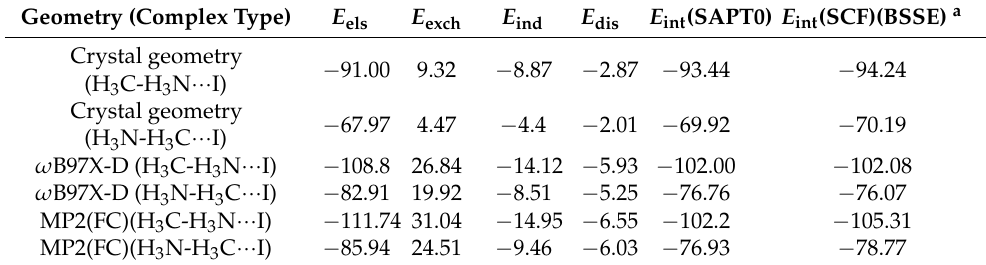
Table 2. Comparison of total and dissected energy SAPT0 components with the SCF based interaction energies of H 3 C-H 3 N ··· I and H 3 N-H 3 C ··· I ion-pairs, obtained on the fixed crystal geometry, and the